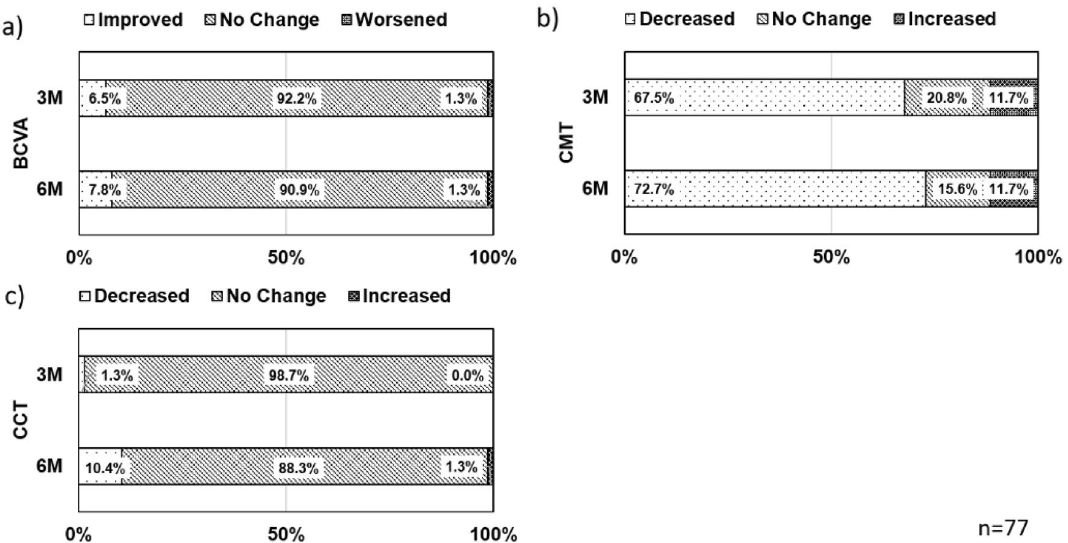
Figure 4. Time course of individual changes in best corrected visual acuity (BCVA), central macular thickness (CMT), and central choroidal thickness (CCT). ( a ) Proportions of patients whose BCVA was improved, unchanged, or worsened by ≥ 0.2 from baseline at 3 and 6 months after treatment. The proportion of patients with improved BCVA was 6.9% at 3 months and 7.8% at 6 months. ( b ) Proportion of patients whose CMT reduced, unchanged, or increased by ≥ 15% from baseline at 3 and 6 months after treatment. The number of patients with reduced CMT increased (from 67.5 to 72.7%) from 3 to 6 M. ( c ) Proportion of patients whose CCT reduced, unchanged, or increased by ≥ 15% from baseline at 3 M and 6 M after treatment. The number of patients with reduced CCT increased (from 1.3 to 10.4%) from 3 to 6